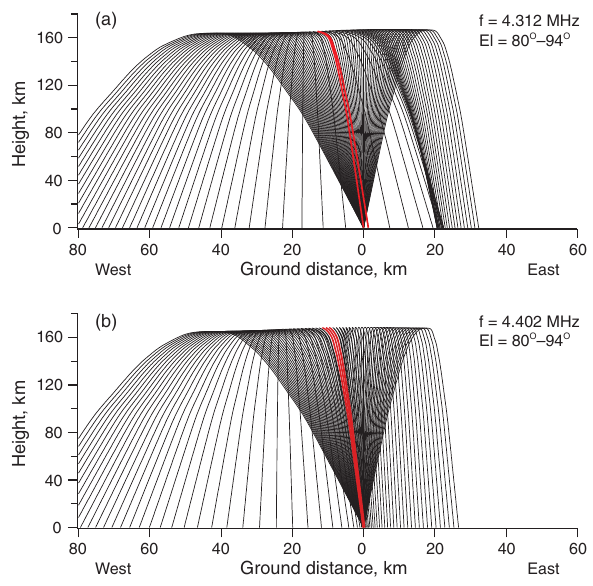
Figure 11. Ray plots for initial elevation angles from 80 to 94 ◦ with increments of 0.2 ◦ at frequencies of 4.312MHz (a) and 4.402MHz (b) . Red lines show ray paths that returned to the re- ceiver